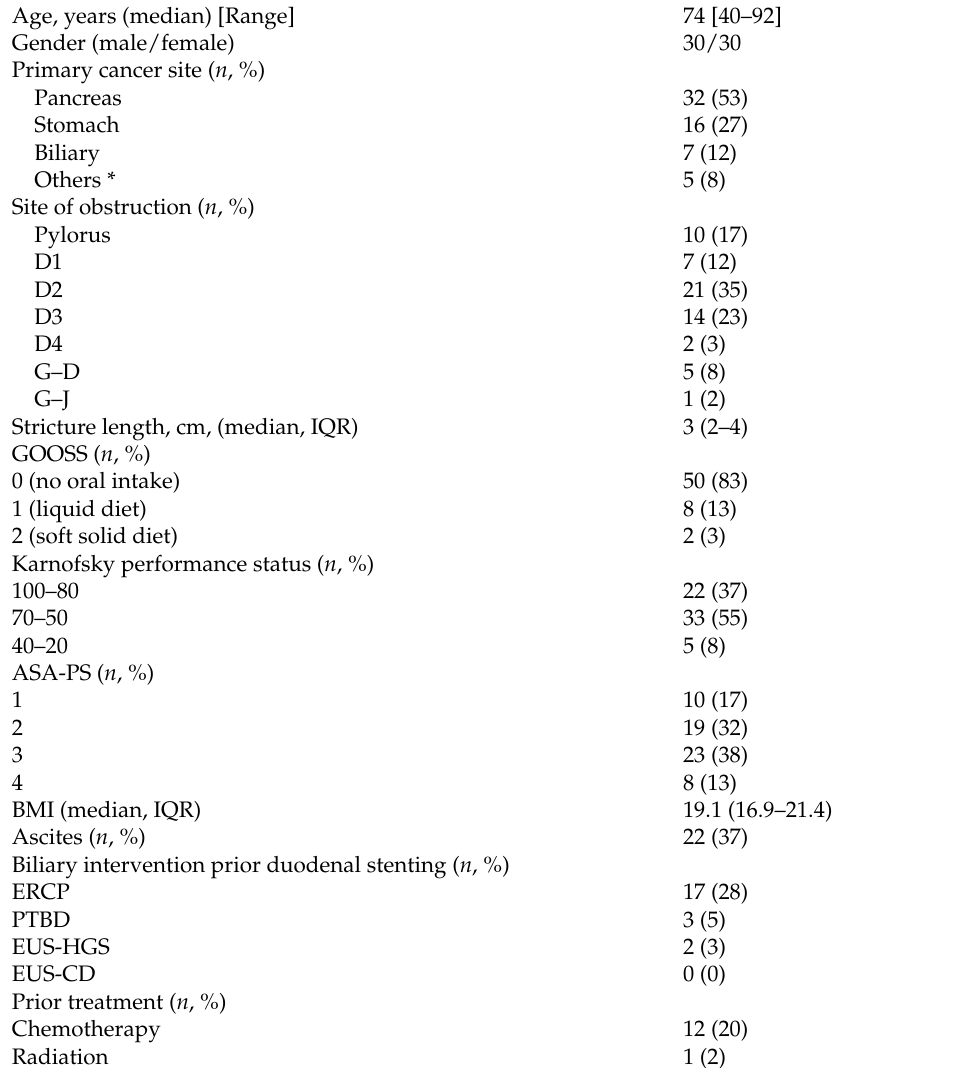
Table 1. Characteristics of 60 patients with malignant GOO who received WallFlex™ Duodenal Soft stents ( n =